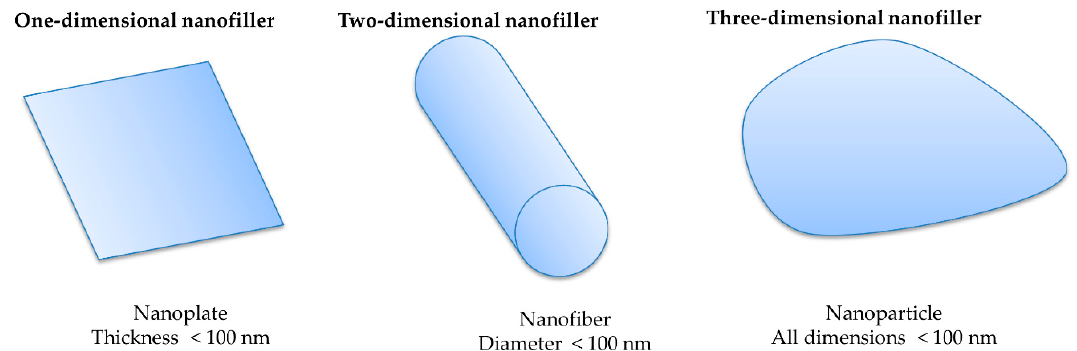
Figure 9. Nano objects used for nanobiocomposites, according to ISO/TS27687 (2008) . Adapted from reference [135]. Copyright IntechOpen, 2011.